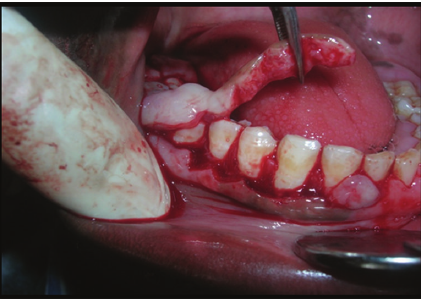
Figure 8: Postoperative view of female patient. It was shown that the left side gingival enlargement was cured.